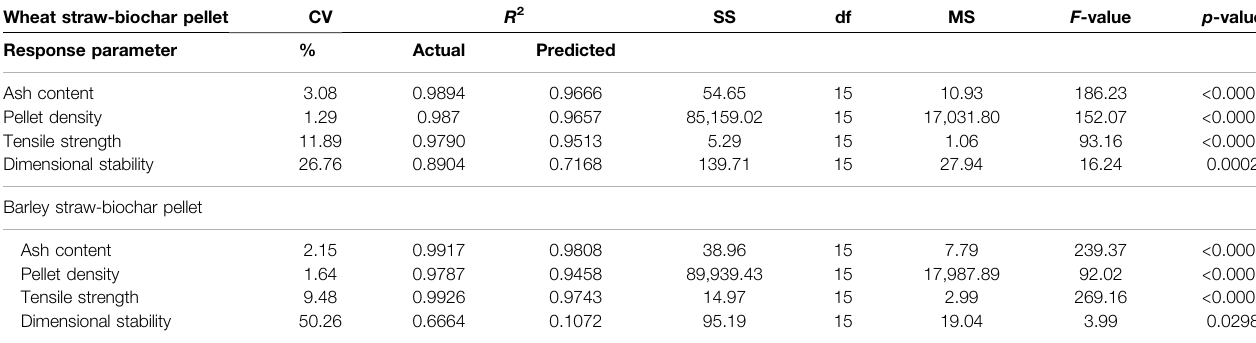
TABLE 5 | Analysis of variance for the quadratic model of UDD responses of wheat and barley straw-biochar pellet at 8% (w.b).